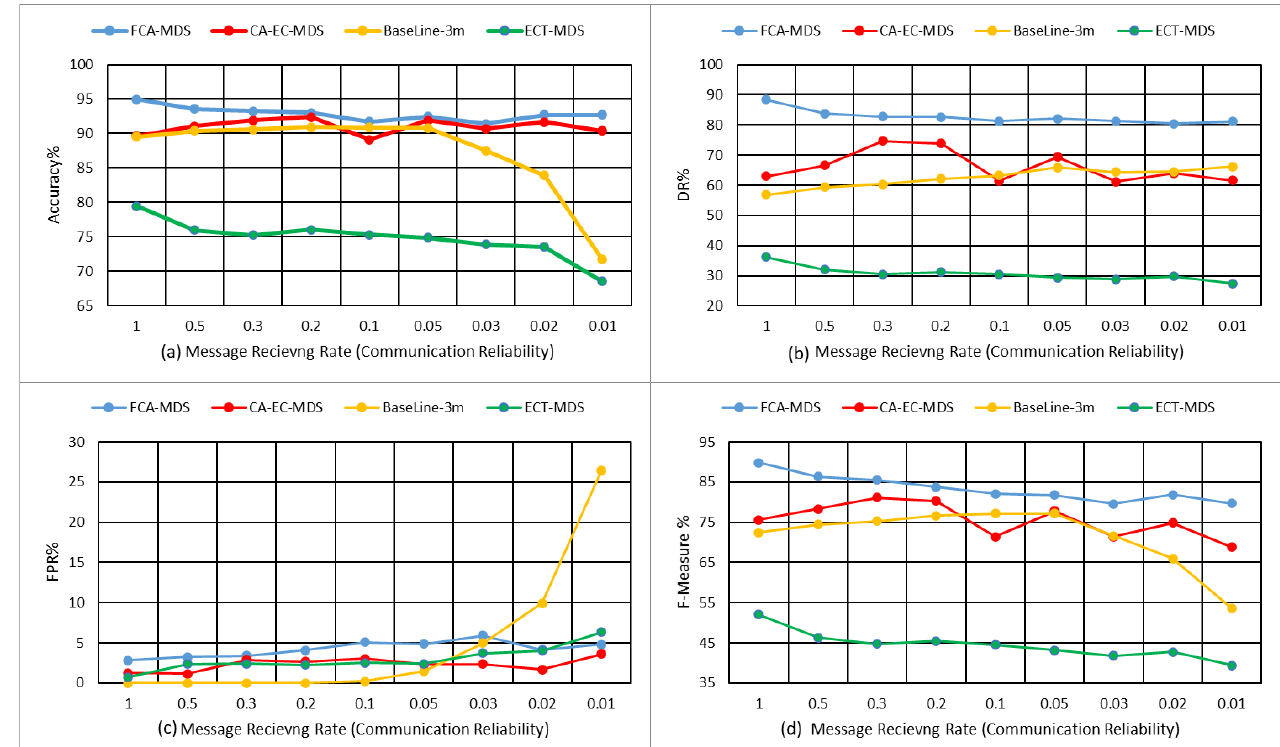
Figure 7. Performance evaluation of the proposed FCA-MDS model in terms of ( a ) accuracy, ( b ) DR, ( c ) FPR, and ( d ) F-measure.